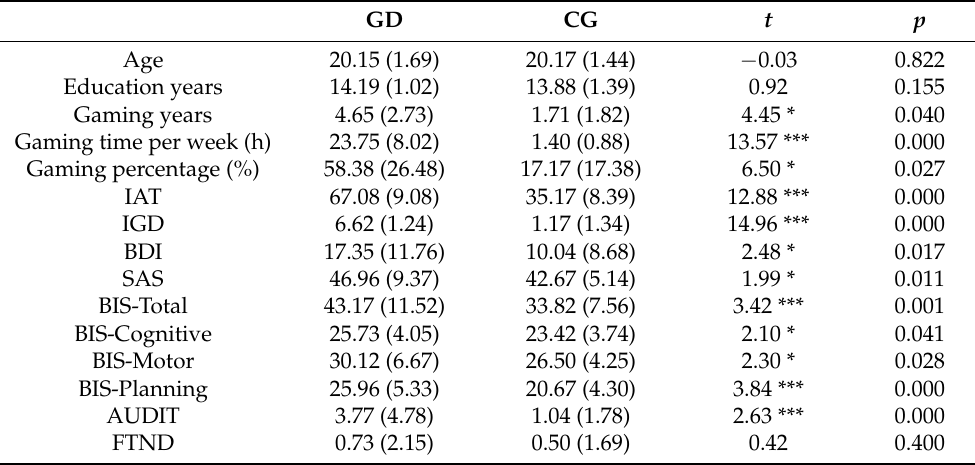
Table 1. Demographic characteristics of the gaming disorder group and control